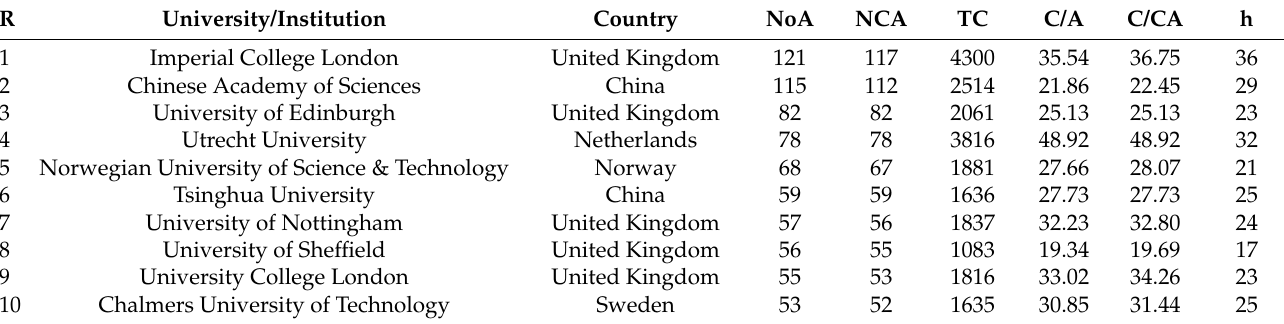
Table 4. Top ten most influential institutions in carbon capture and utilization